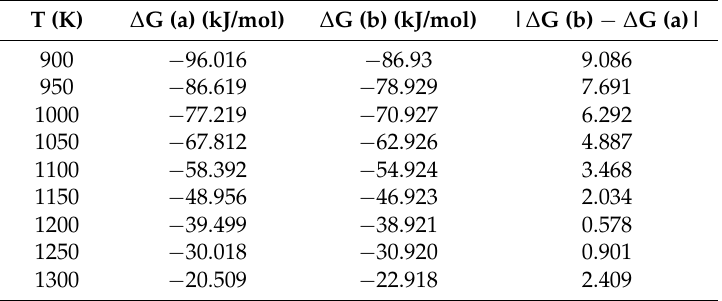
Comparison between ∆ G f values of (a) this study and (b) [25] for the